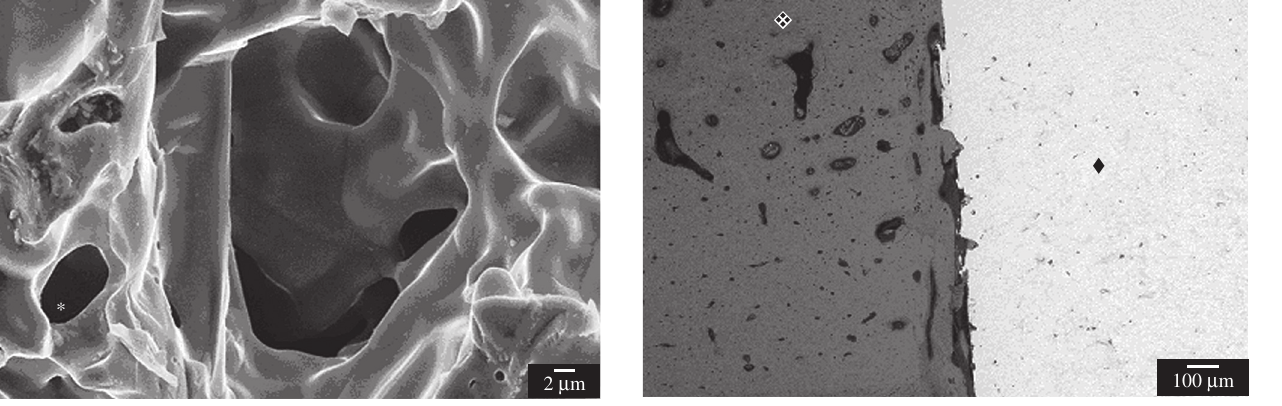
Figure 3. SEM detail of interconnected pores (*).